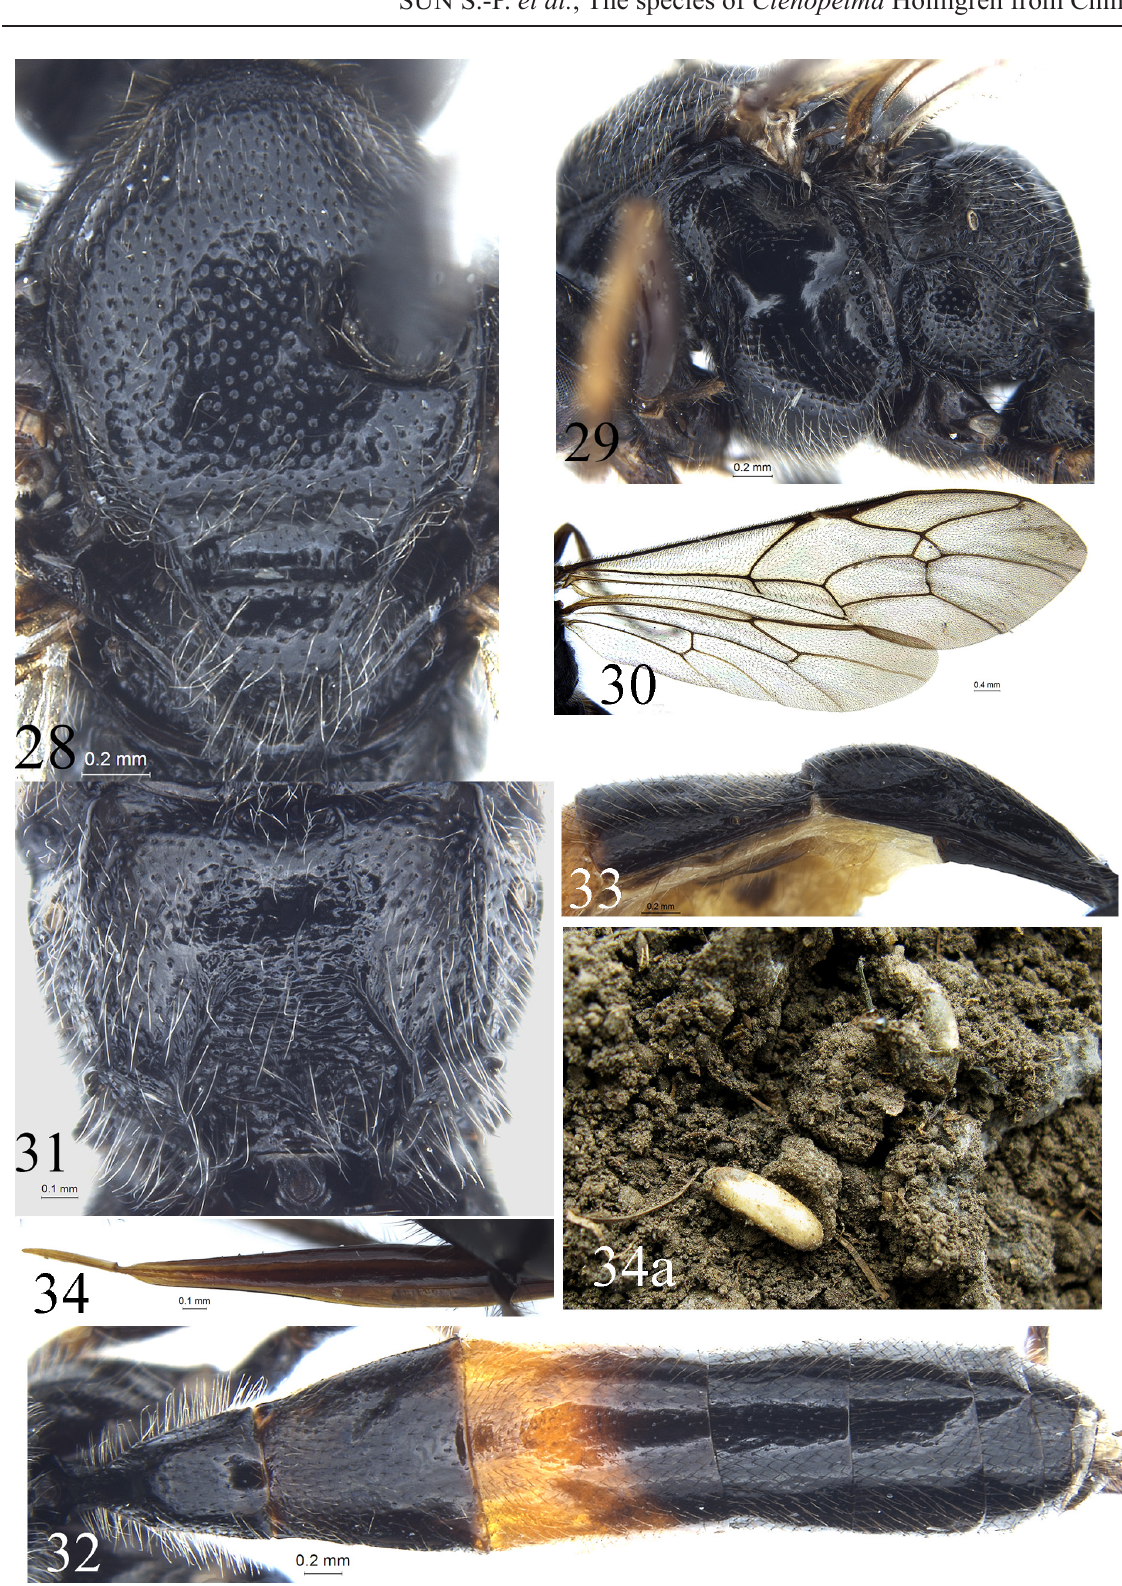
Figs 28–34. Ctenopelma rufofasciatum Sheng, Sun & Li sp. nov., holotype, ♀ (GSFGPM). 28 . Mesoscutum and scutellum. 29 . Mesosoma, lateral view. 30 . Wings. 31 . Propodeum. 32 . Metasoma, dorsal view. 33 . Ttergites 1–2, lateral view. 34 . Ovipositor, lateral view. 34a .